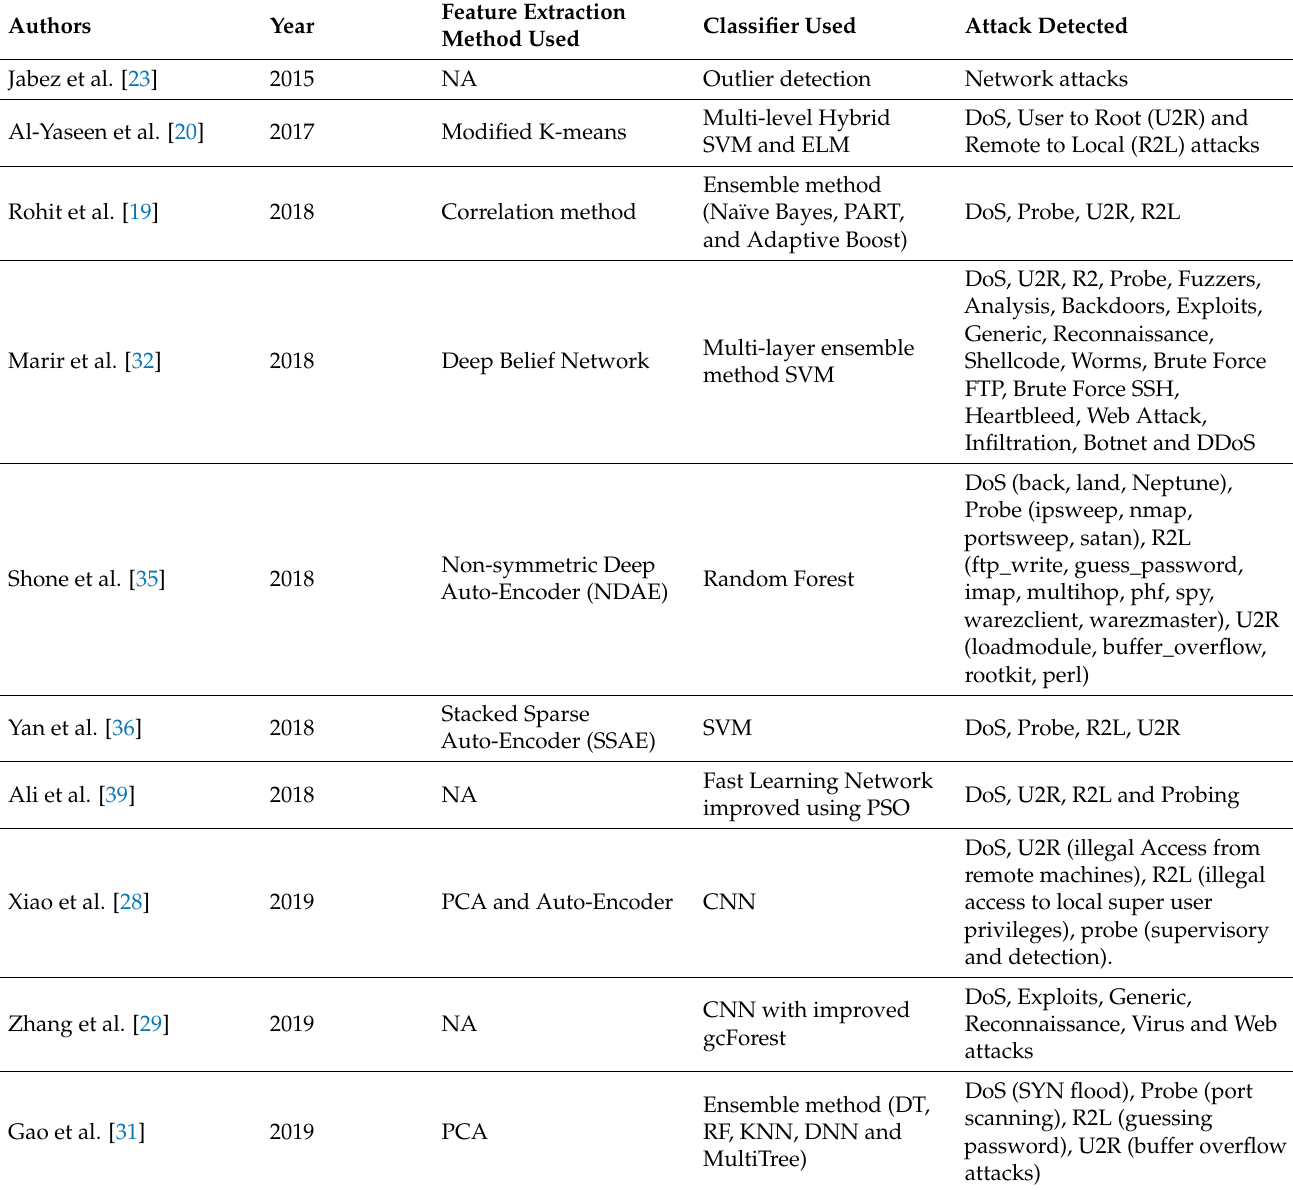
Table 4. Summary of Literature Review (Feature extraction method and